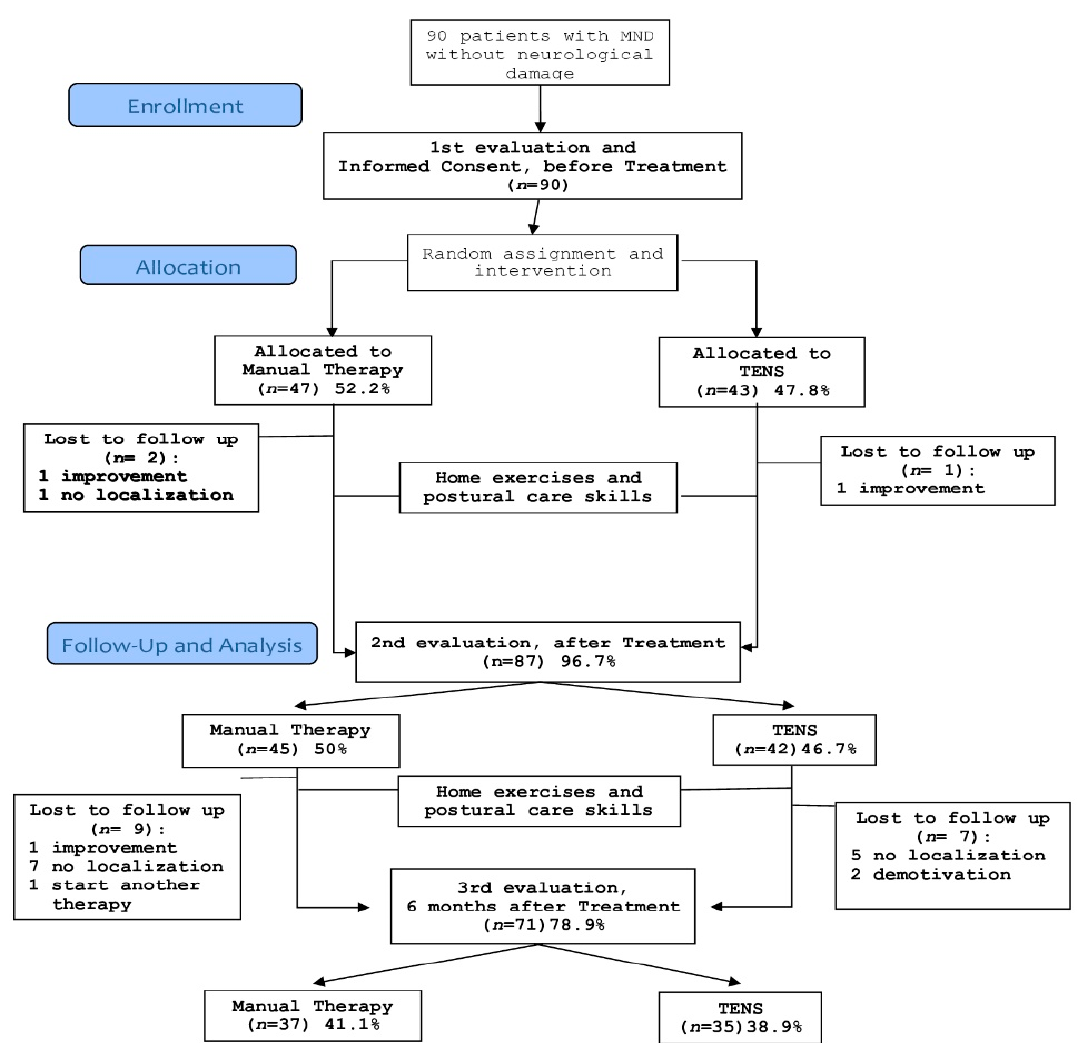
Figure 2. Flow chart: Progress of patients through trial. Table 2. Sociodemographic characteristics and the prognostic variables at baseline.